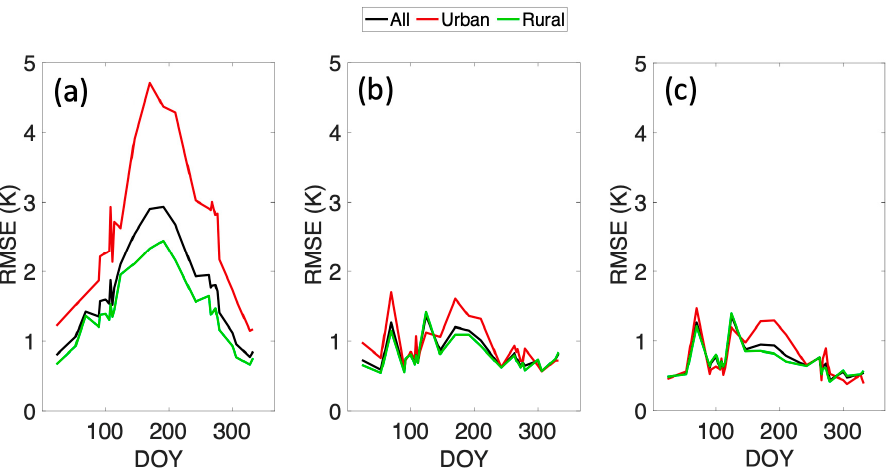
Figure 10. Inter-sensor biases between MODIS and Landsat patch-level LST. ( a – c ) display the RMSE of original MODIS LST, adjusted MODIS LST and predicted LST, respectively, against resampled Landsat LST. The black, red and green lines denote the entire scene, urban areas and rural areas, respectively.